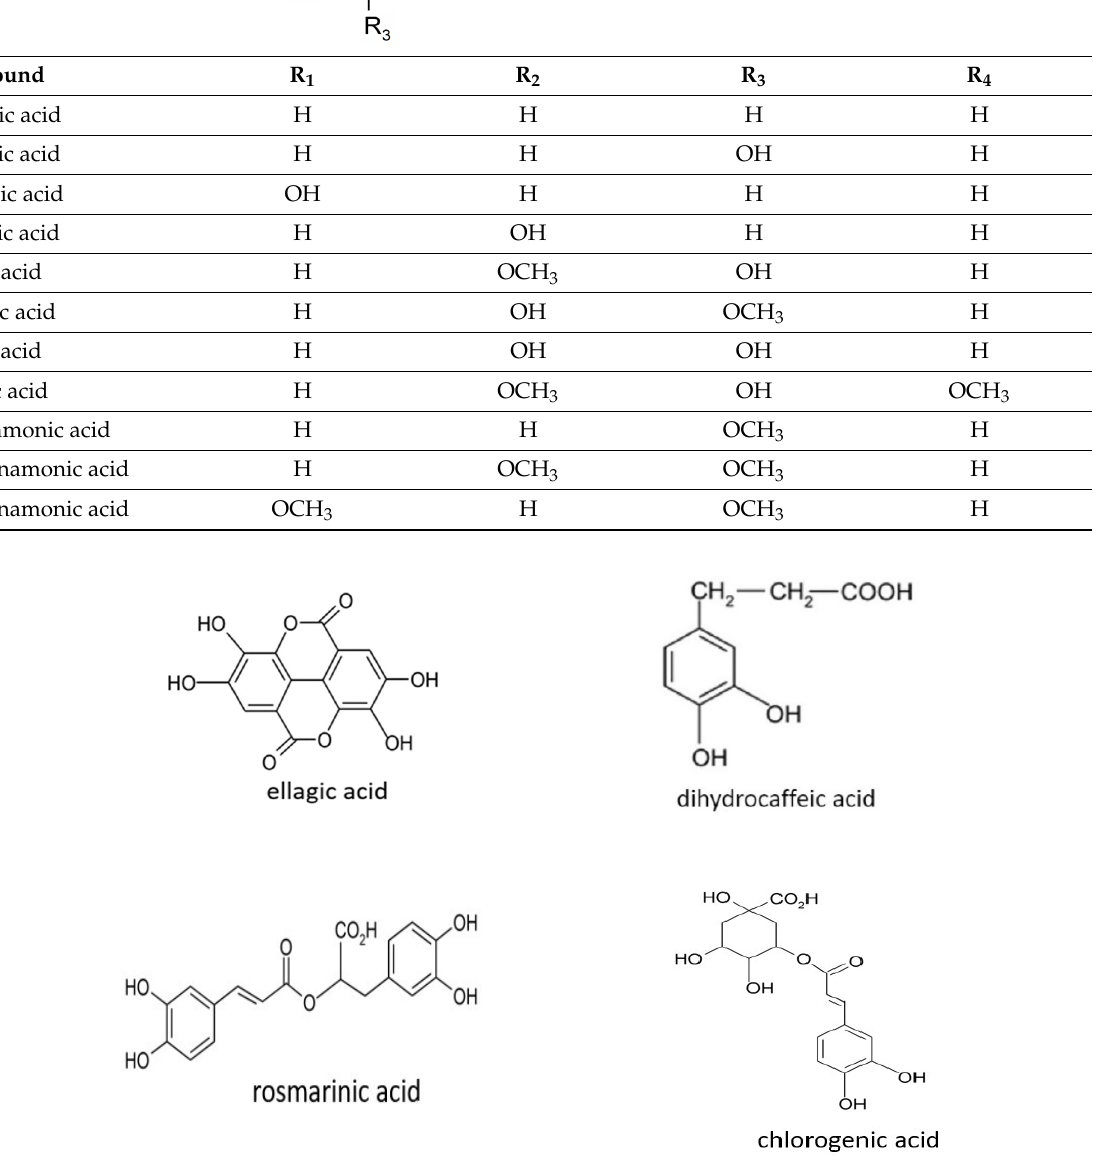
Figure 4. Structural formulas of selected depsides and other phenolic acids.